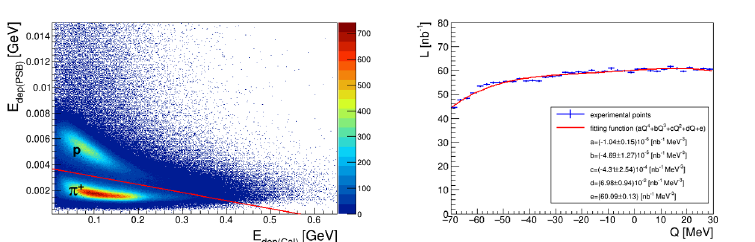
Figure 2. Left: experimental spectra of the energy loss in the Central Detector. The applied cut is shown as a red line. Right: Luminosity calculated for quasi-free pd → ppn spec reaction (blue points) with fitted 4 degree polynomial function (red